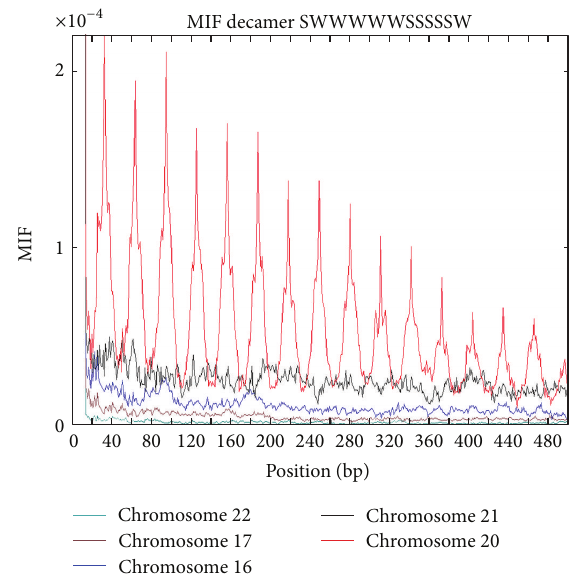
Figure 6: The MIF profiles of the 12-mer SWWWWWSSSSSW in some Homo sapiens chromosomes.